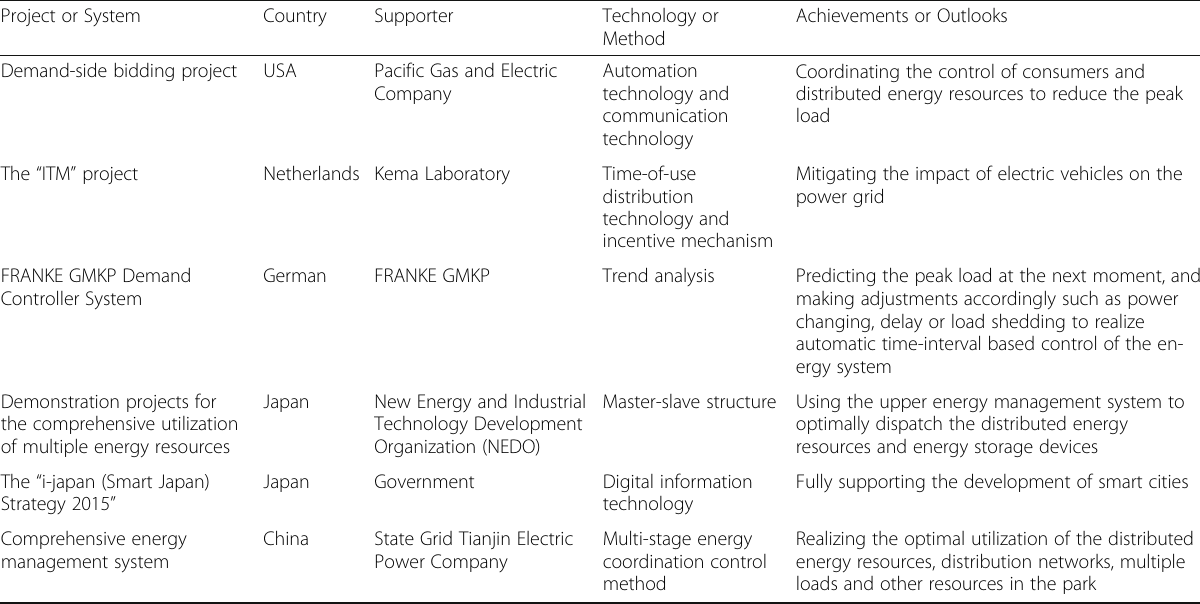
Table 1 Software development and application of demand response worldwide Project or